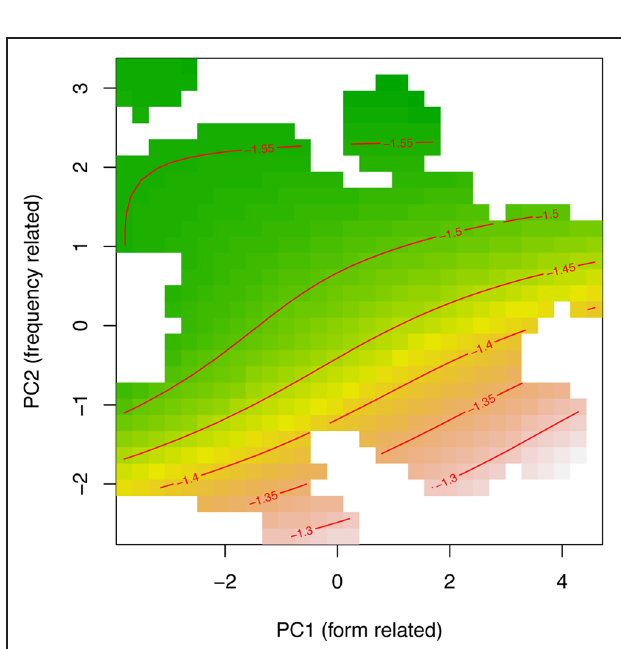
FIGURE 6 | Tensor product smooth for the non-linear interaction of the principal component for form-related neighboring words (PC1) and frequency of occurrence (PC2). Green indicates shorter response latencies, and yellow-to-brown indicates longer response latencies at 48 ms SOA.